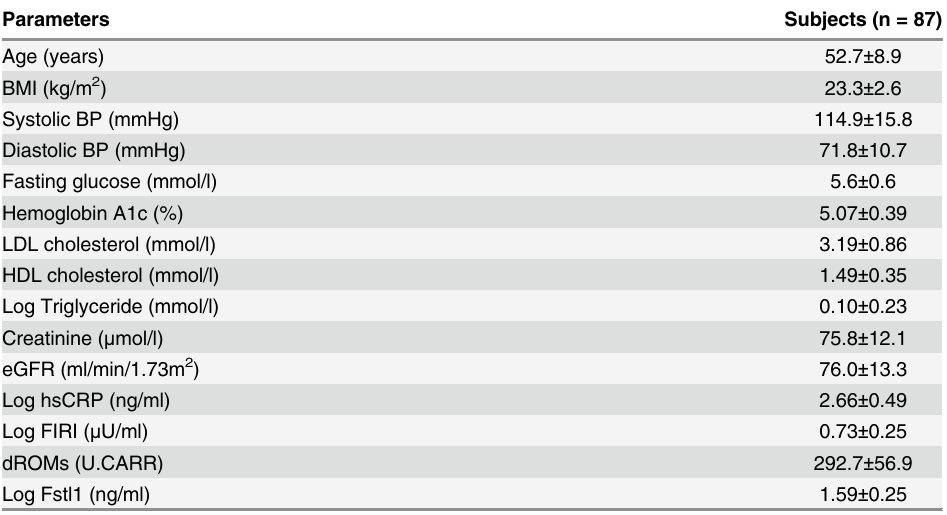
Table 1. Clinical characteristics of all